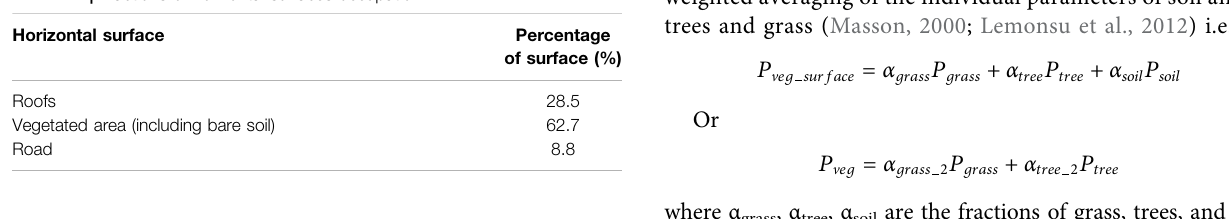
TABLE 1 | Fractions of horizontal surfaces occupation.